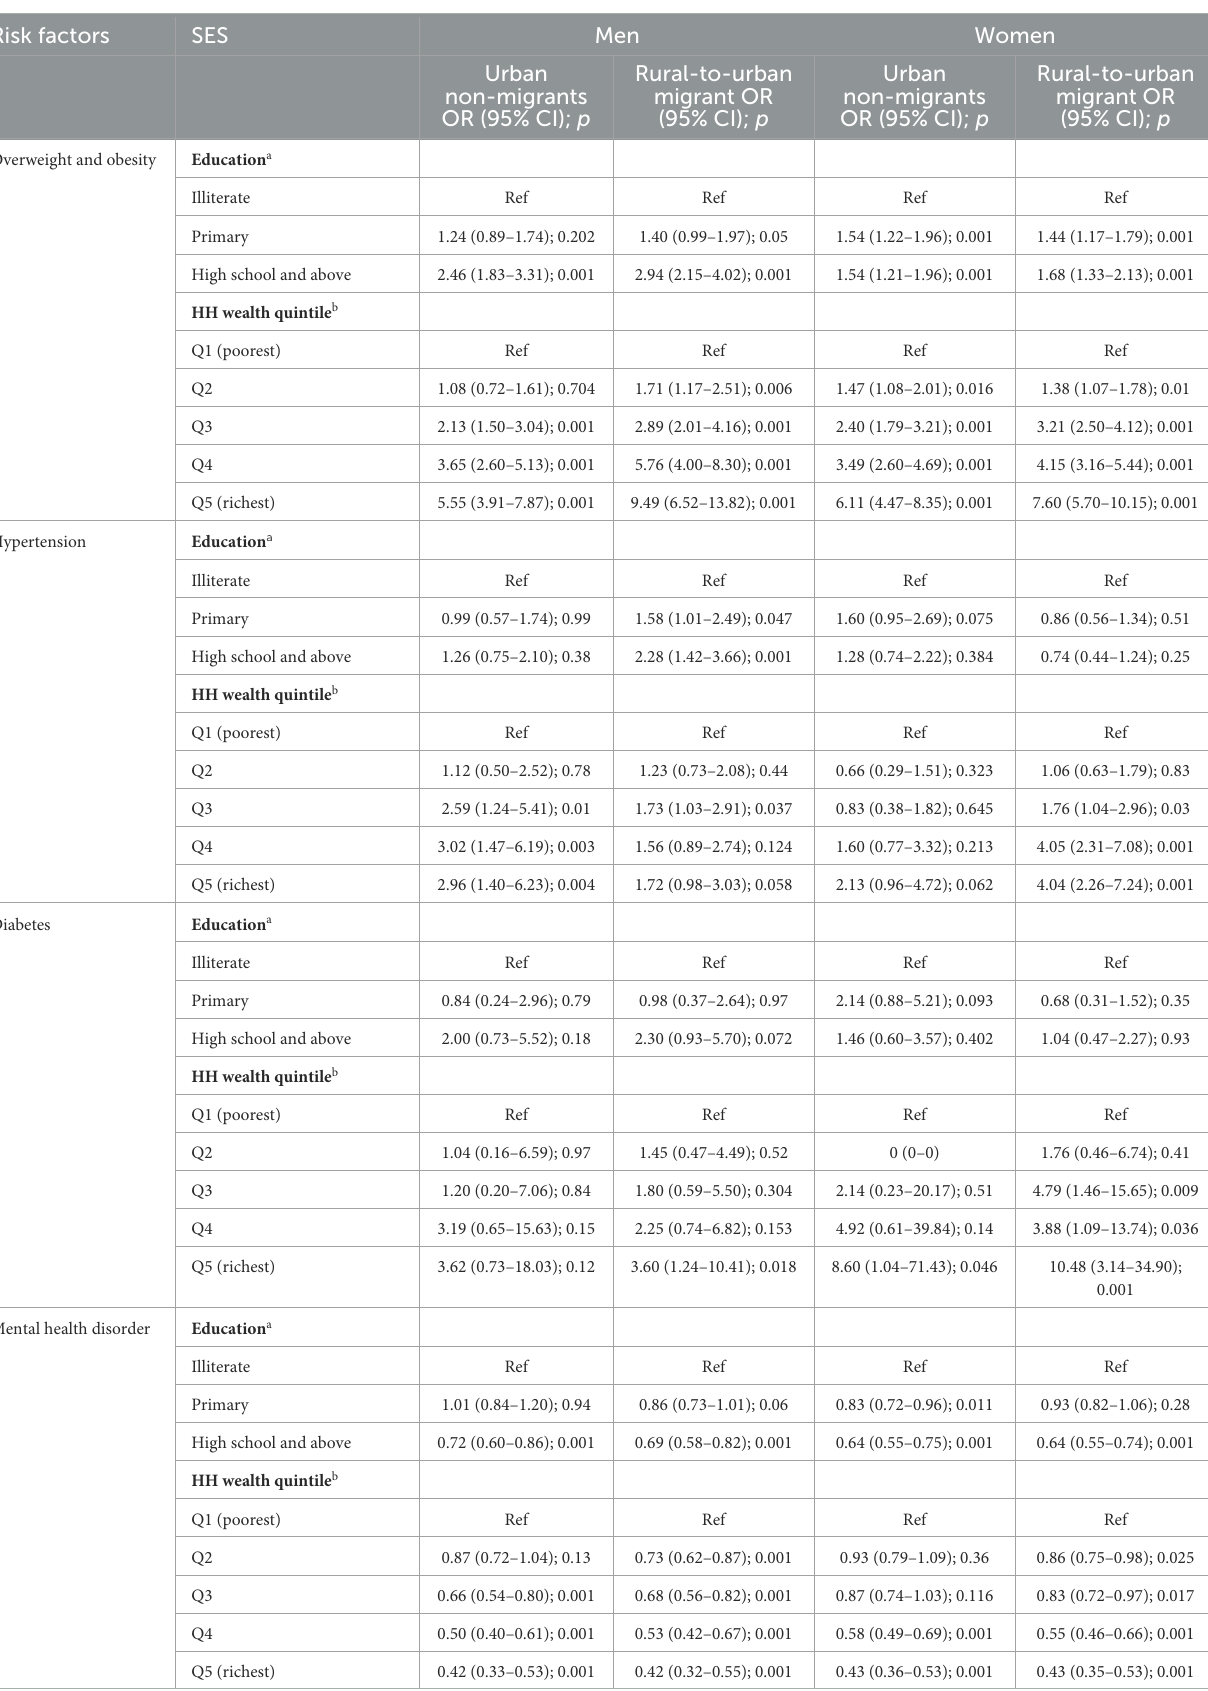
TABLE 3 Association between socio-economic status and CVDs risk factors among rural-to-urban migrant and urban resident. Risk